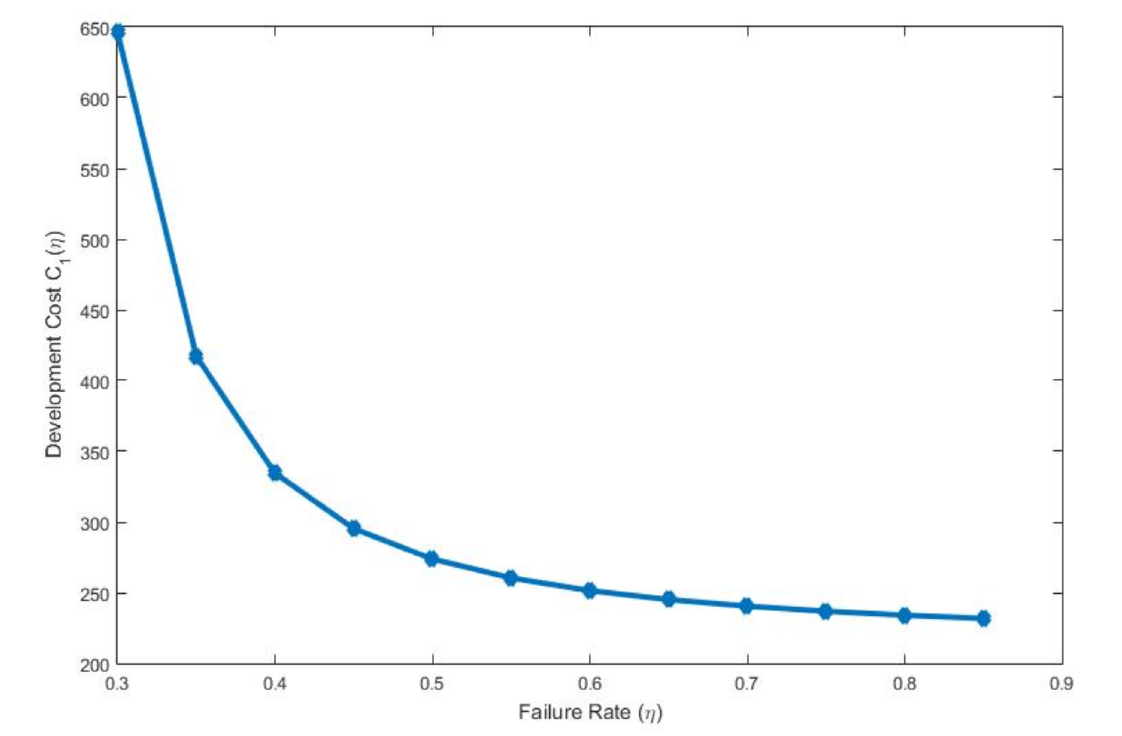
Figure 3. Variation in development cost C 1 ( η ) with varying system failure rate ( η